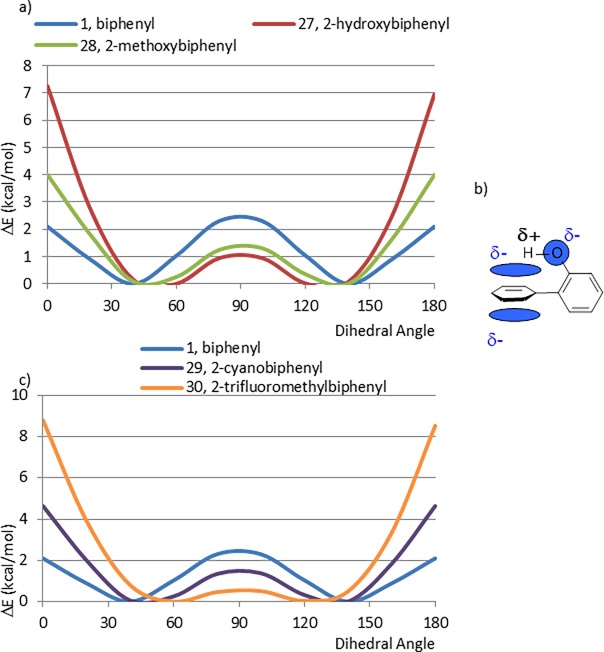
a) Comparison between CEPs of biphenyl and ortho substituted hydroxyl and methoxy derivatives, b) Diagram that represents the attractive interaction between the electrostatically positive hydrogen of the hydroxyl group and the negative pi cloud of the pendant phenyl ring, c) Comparison between CEPs of biphenyl and ortho substituted cyano and trifluoromethyl derivatives.